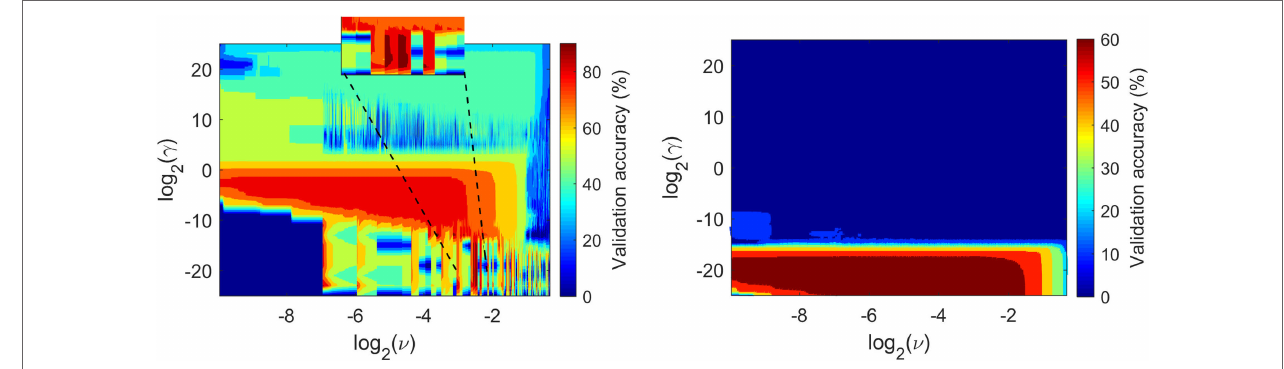
FIGURE 5 | Cross-validation accuracy variation with γ and ν for the one-class support vector machine-based learned model using features of kernel principal component analysis (left) and standard principal component analysis.